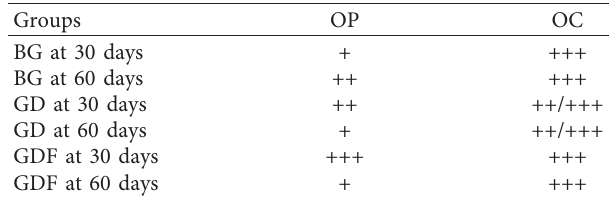
Figure 5: Representative images for osteopontin (a) and osteocalcin (b) immunolabeling at 30 and 60 days postoperatively for the experimental groups and positive control group. Original magnification, × Table 1: Immunolabeling results at 30 and 60 days.